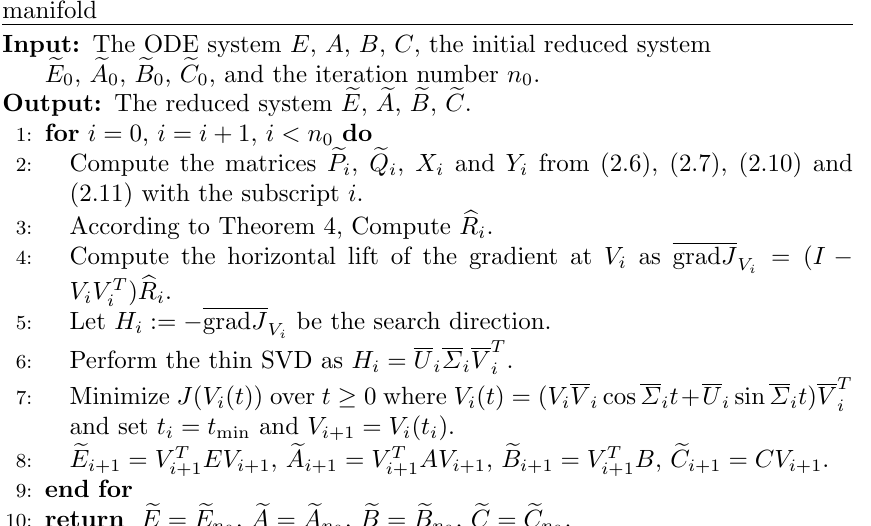
Algorithm 1 H 2 optimal model reduction of ODE systems on the Grassmann